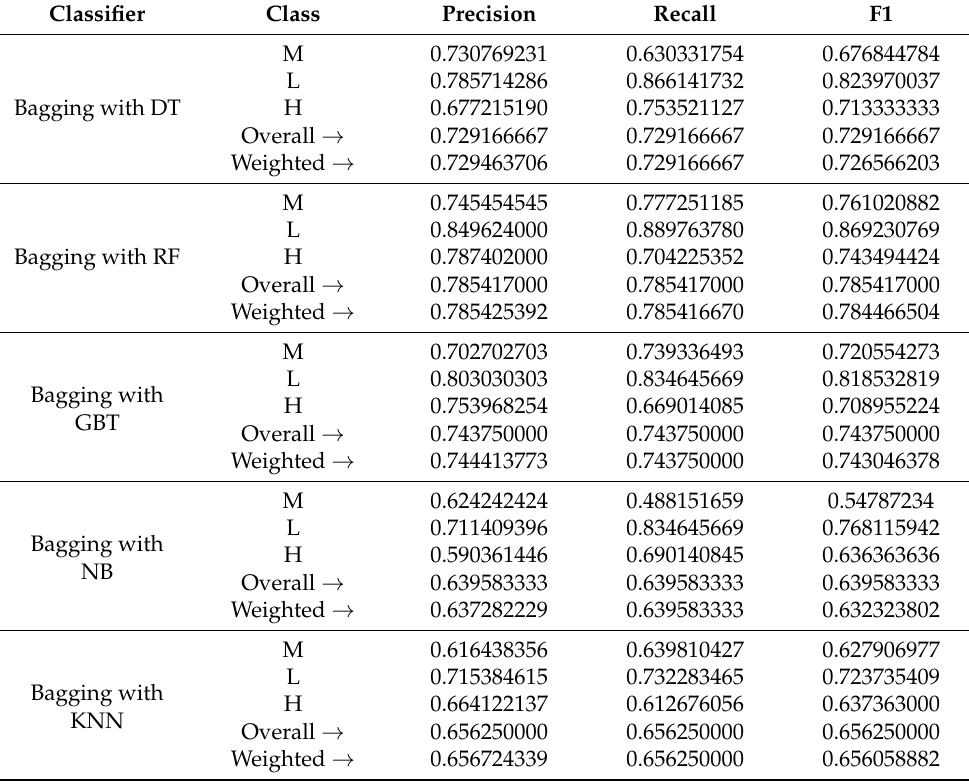
Table 4. Performance metrics for all ML models—with ensemble method I